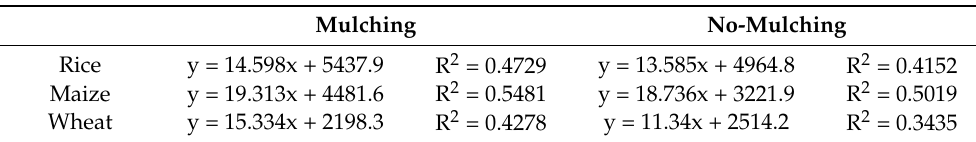
Table 2. Effects of straw mulching and no-mulching with nitrogen application rate on yield. Adapted with permission from Ref. [140]. 2019, Wang, X. Mulching y = 14.598x +